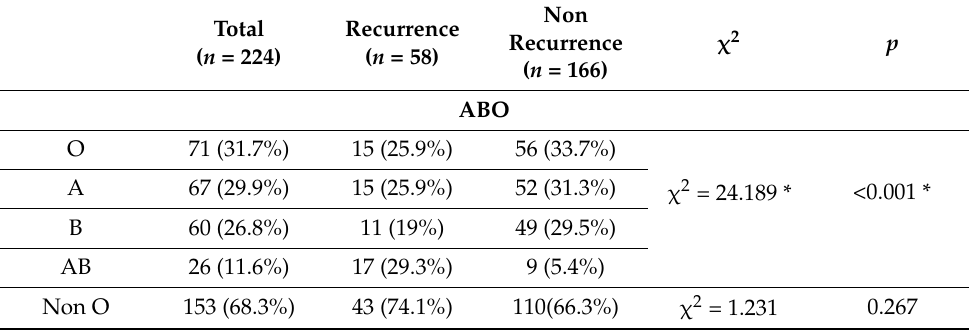
Table 2. Genotyping of the five SNPs among the two studied groups of